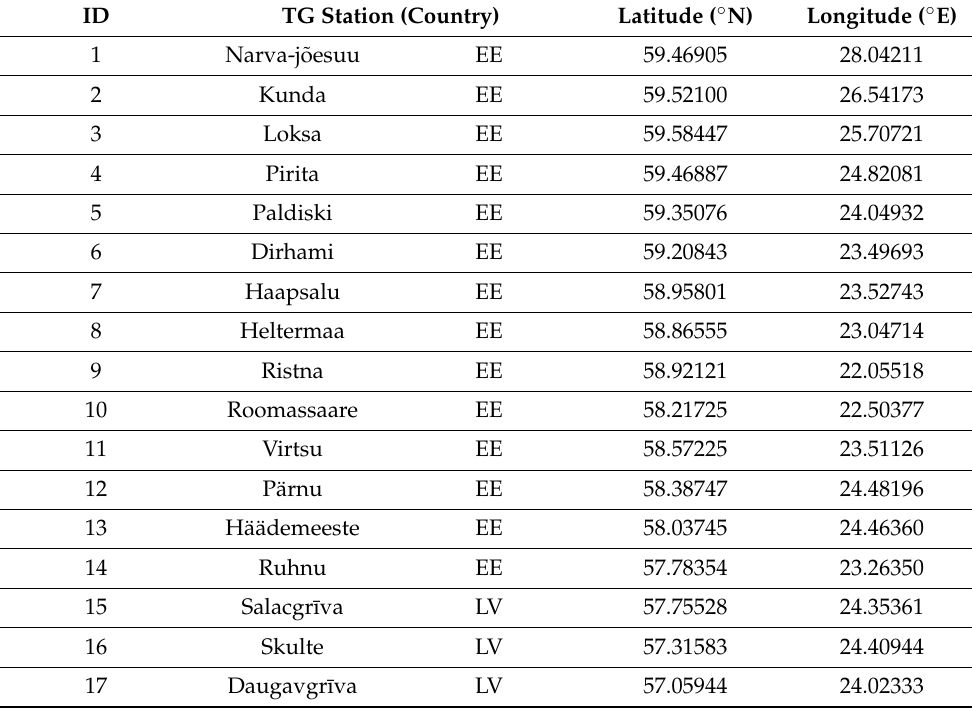
Table A1. The used tide gauge